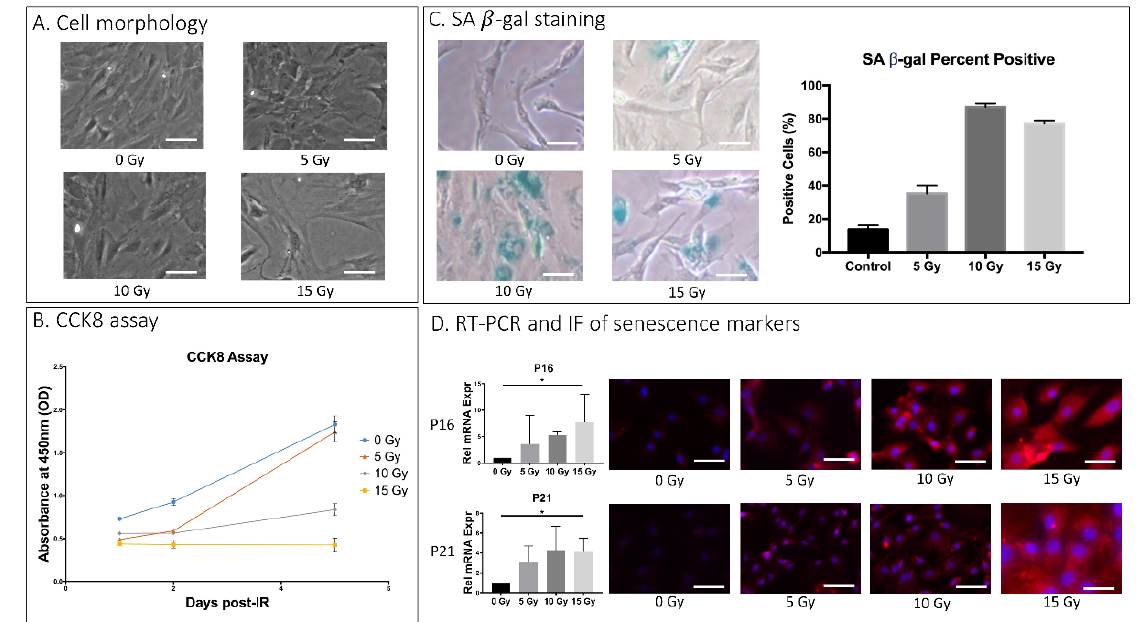
Figure 1. IR-induced AF cellular senescence. Rat AF cell cultures were exposed to a single dose of 0, 5, 10, and 15 Gy of IR and further incubated for 5 days before being analyzed for SASP. ( A ) Effects of IR on gross cell morphology as assessed by light microscopy. ( B ) Effects of dose and duration of IR treatment on cell proliferation in rat AF cell culture as quantitatively measured by CCK8 assay. Y-axis, proliferation level by absorbance. X-axis, time in days post–ionizing radiation. ( C ) Senescence-associated β -galactosidase (SA- β gal) assay of rAF cell cultures 5 days post-treatment with different IR doses. Cultures treated with 10 or 15 Gy IR resulted in 80% of cells stained positive for SA- β gal. ( D ) IR increased expression of cellular senescence markers, p16 and p21 in a dose-dependent manner as measured by qRT-PCR for mRNA levels (left) and by immunofluorescence (IF) for protein levels (right). Data shown as an average of n = 3 with one standard deviation. On microscopic images, the white bar for scale measures 20 μ m. * p ≤ 0.05.